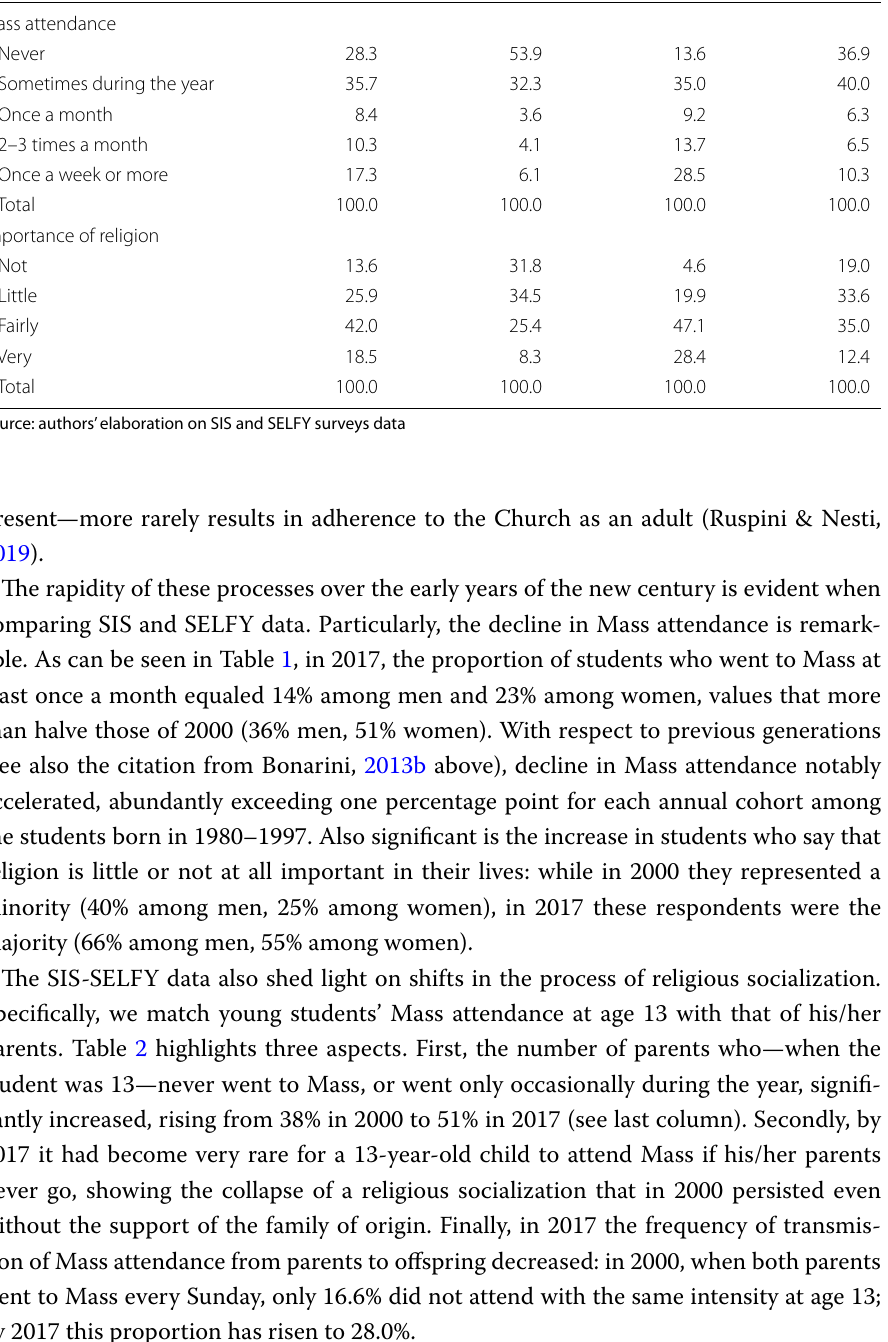
Table 1 Mass attendance and importance of religion in life at interview (column %)